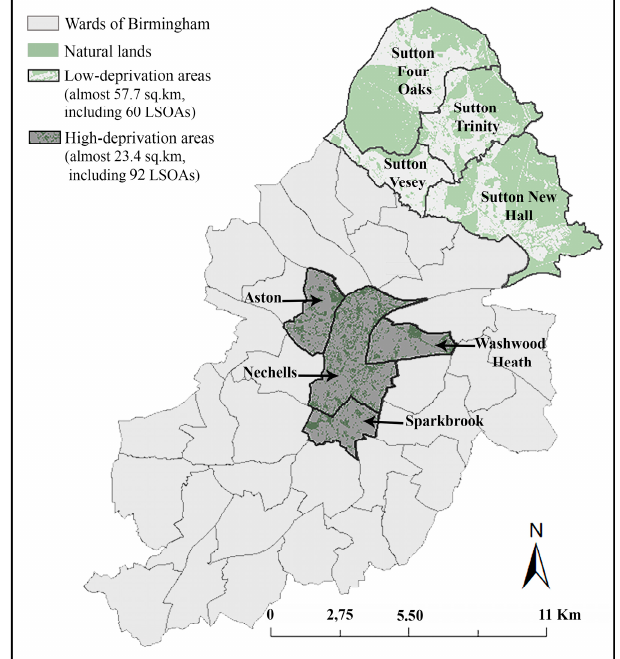
Figure 1. Locations of low- and high-deprivation areas in Birmingham. (OS open data Boundary-line © Crown copyright/database right 2012 and OS MasterMap data © Crown Copyright/database right 2012. An Ordnance Survey/EDINA Digimap supplied service.)